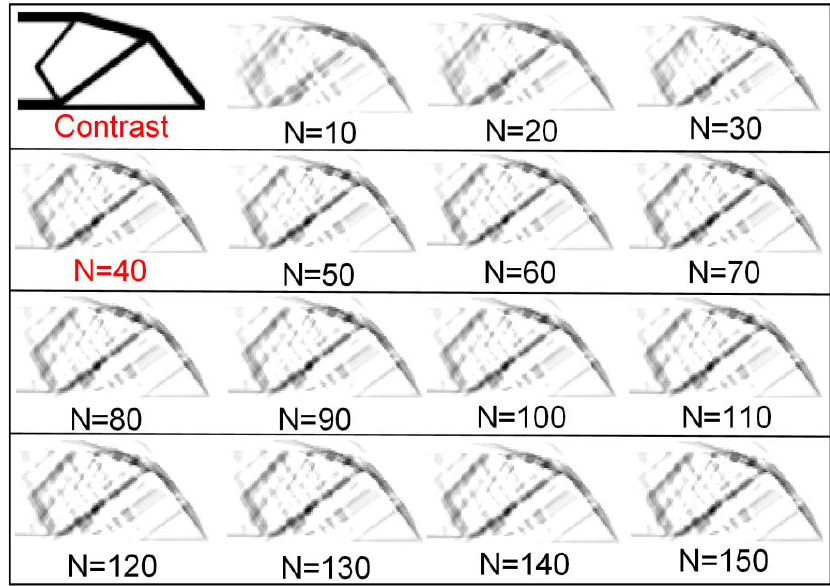
Figure 7. The prediction result of training 2 with different N.